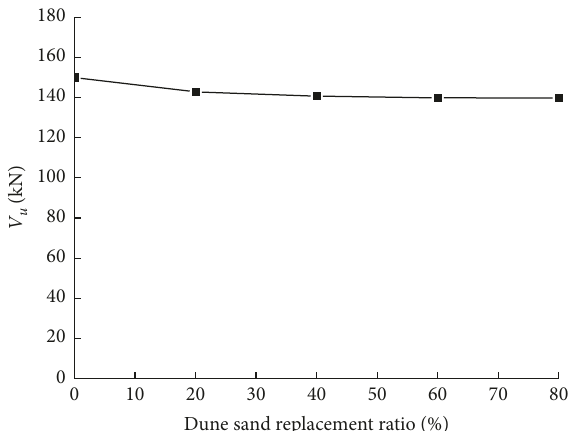
Figure 8: Relationship of shear strength and dune sand replacement